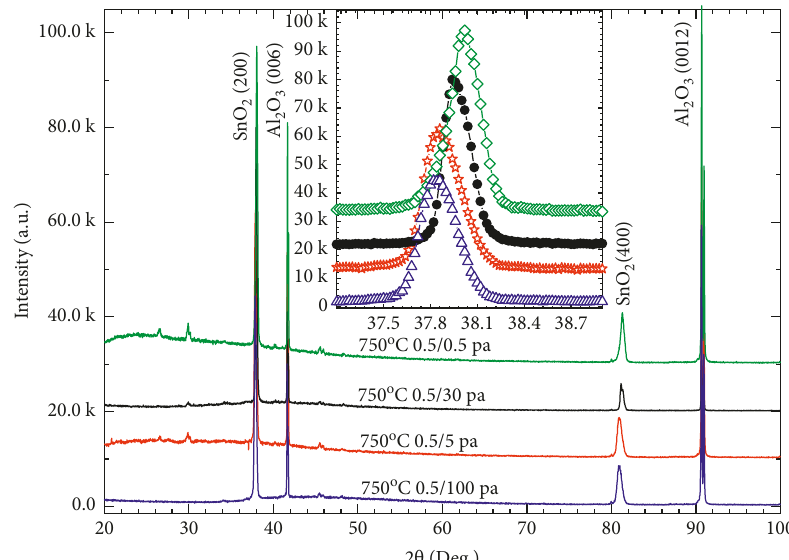
° C, 0.5Pa oxygen pressure, and different annealing oxygen